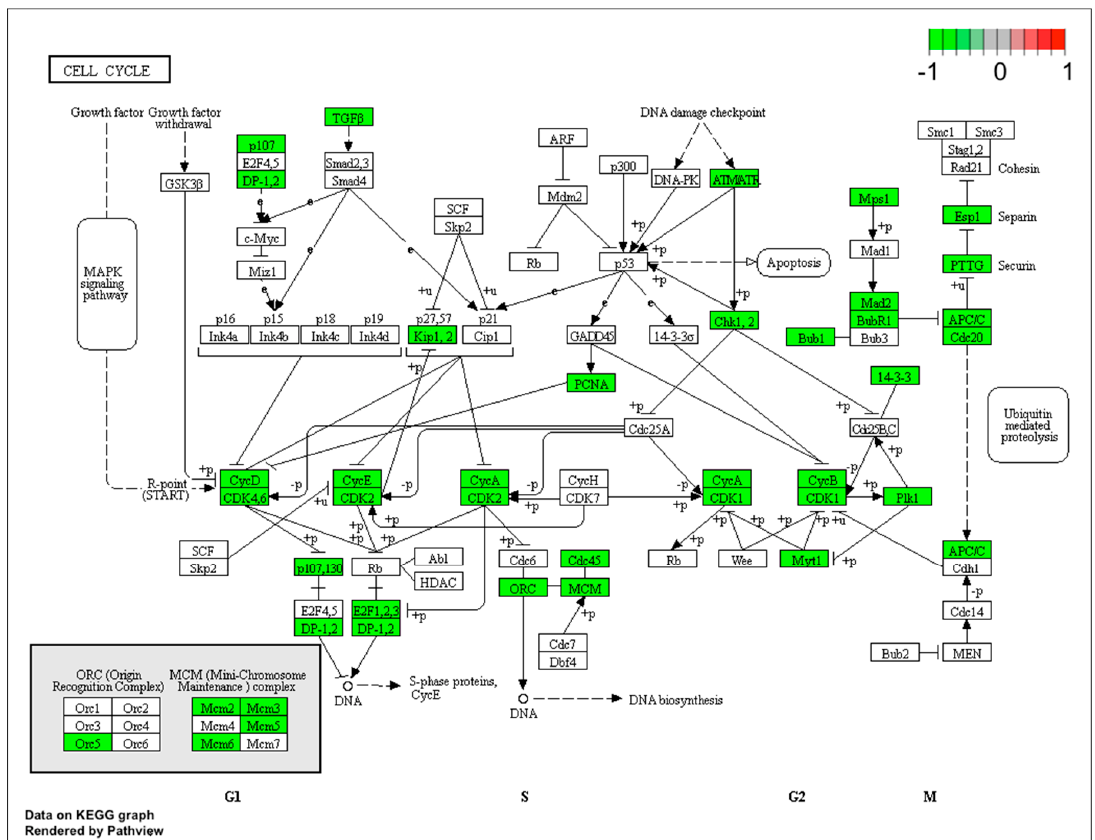
Figure 5. Graph of genes and processes involved in the pathway 04110: Cell cycle. The scheme shows genes and relationships between them. Additionally, the diagram indicates the genes up- or downregulated in our analysis. Solid arrows indicate a direct effect on specific gene expression while dotted arrows indicate gene involvement in a process or pathway. This allows an in-depth understanding of the effects of specific gene dysregulation on the selected process.